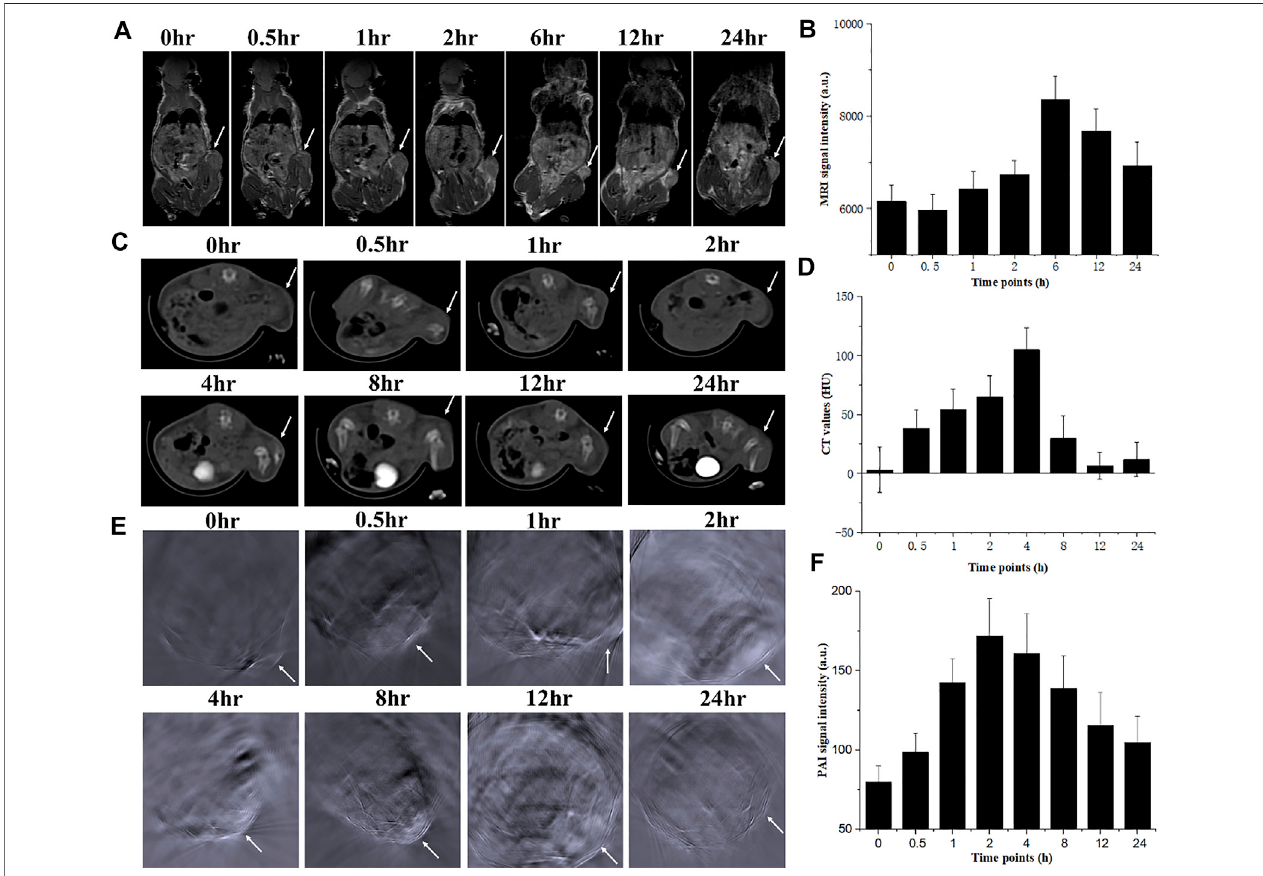
FIGURE 4 | In vivo dynamic triple images of NMOF5454@Pt in the 4T1 breast tumor mouse model and relative signal increments at different time points for 24 h. (A) , (B) Coronal MRI images; (C) , (D) axial CT images; (E) , (F) axial PAI images. White arrows denoted the tumor sites.